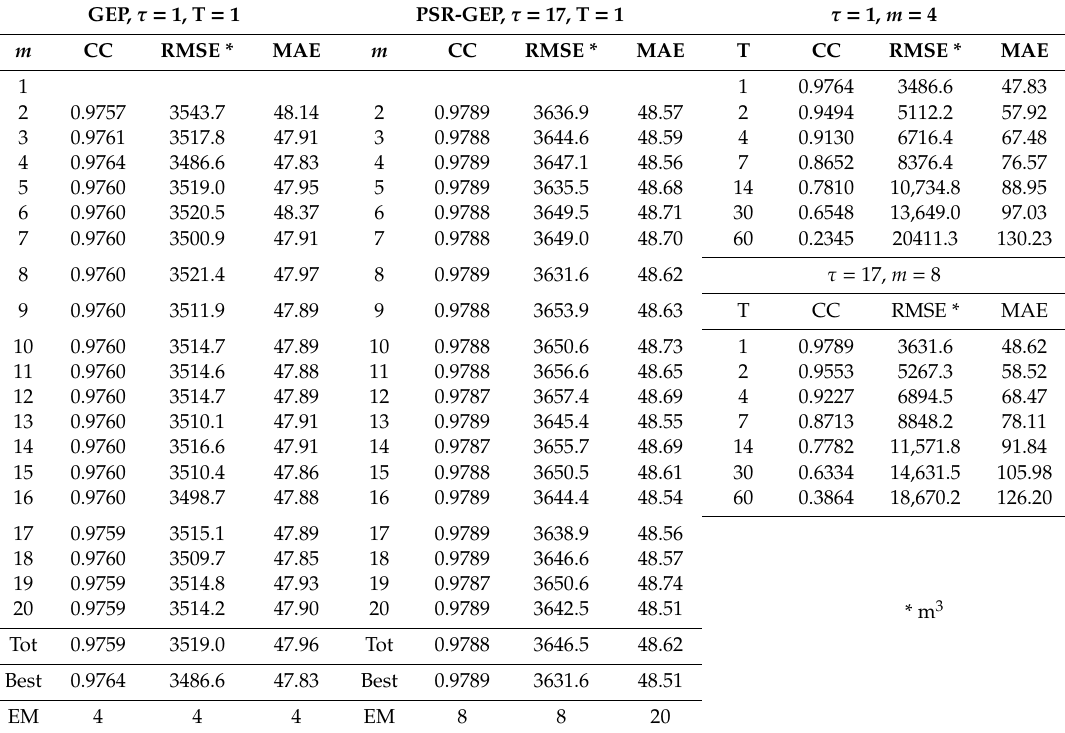
Table4. FitnessvaluesforGEP(geneexpressionprogramming)andPSR-GEP(phasespacereconstructed GEP) methods in di ff erent embedding dimension lag time and lead